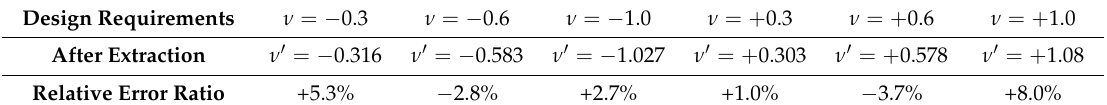
Table 1. Relative errors of Poisson’s ratio between the extracted configurations and design requirements ( ν = ν ZX = PRZX ).